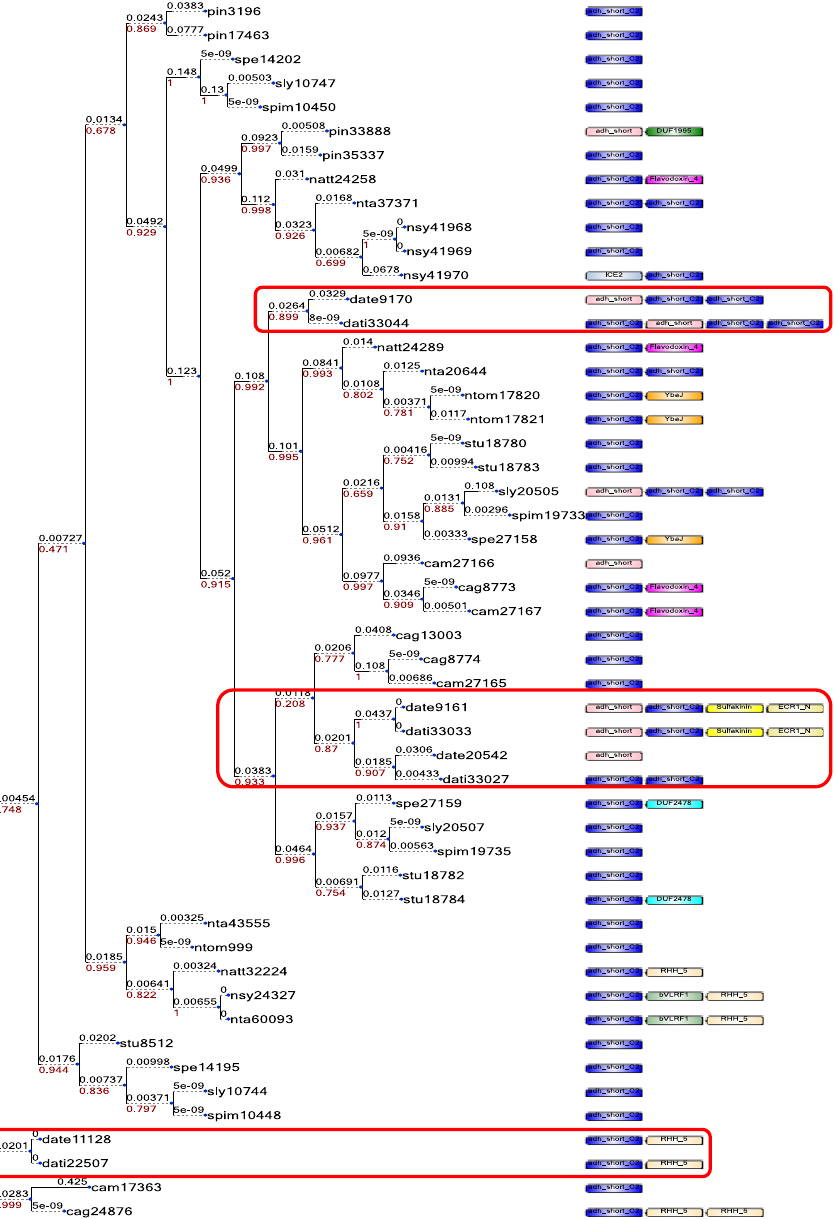
Figure 6. Four copies of the tpr I gene for both genomes were observed (highlighted with a red box). The gene date9161 (Teotihuacán) and dati33033 (Ticumán) have two different domains compared with the rest of the tpr I genes of Datura ; Sulfakinin (PF08257) and ECR1_N domain (PF14382). Different architecture is showed for the tpr I genes, date9170 and dati33044. However, the gene dati33044 (Ticumán) have one additional domain of adh_short_C2 (PF13561), in comparison with its homologous date9170 (Teotihuacán). Likewise, dati33027 showed and additional adh_short_C2 domain in comparison with its closer homologous date20542. The Ticumán plant produced 31.95-fold tropine concentration than Teotihuacán. This chemical differentiation in tropine concentration could be related with this additional domain (adh_short_C2) that was observed in the Ticumán tpr I genes mentioned above. Another gene copies of tpr I, date11128 (Teotihuacán) and dati22507 (Ticumán) have the domain, RHH_5 (PF07878), this domain has been described as a toxin–antitoxin system